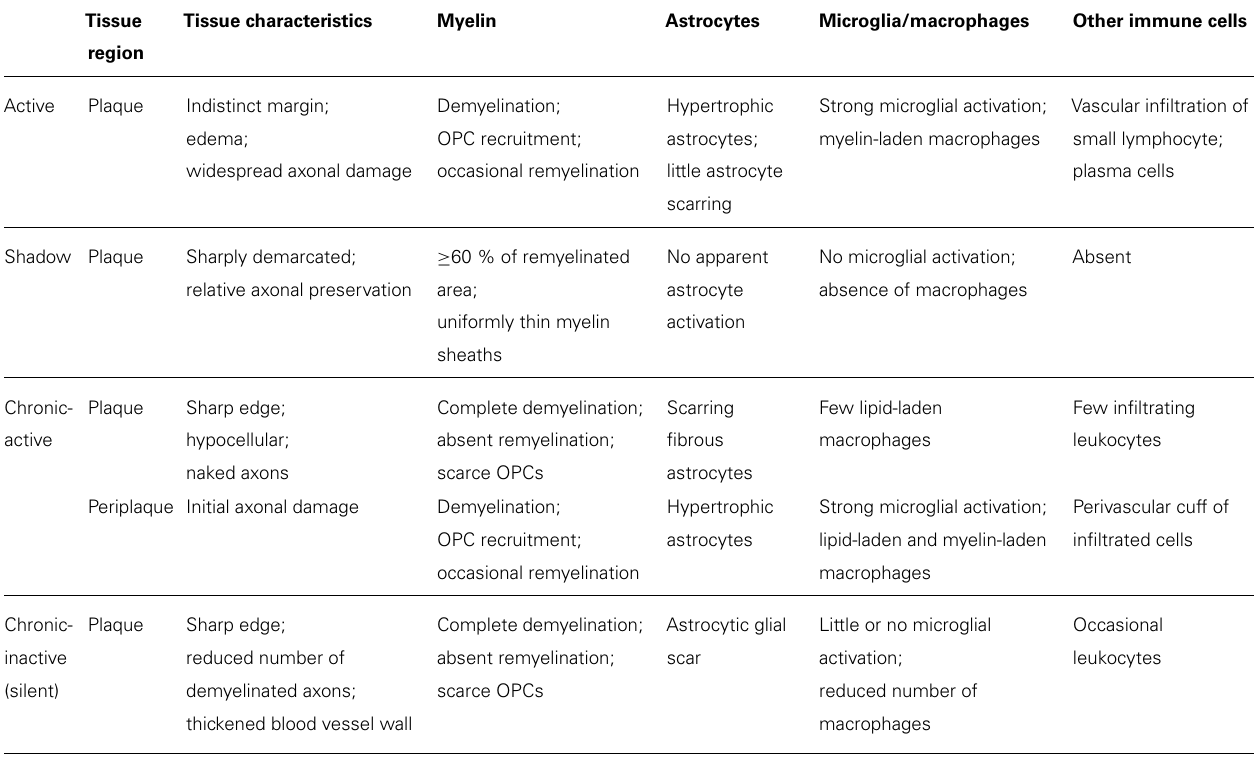
Table 1 | Summary of the histopathological characteristics of the multiple sclerosis